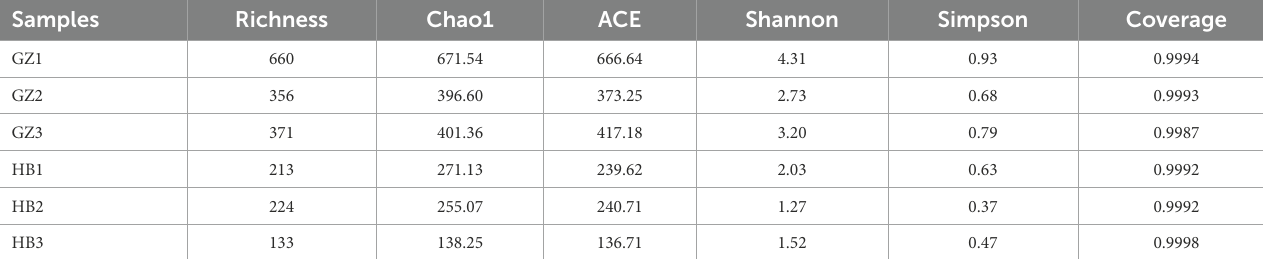
TABLE 2 Alpha diversity of microbial communities in Gastrodia elata f.glauca tubers.